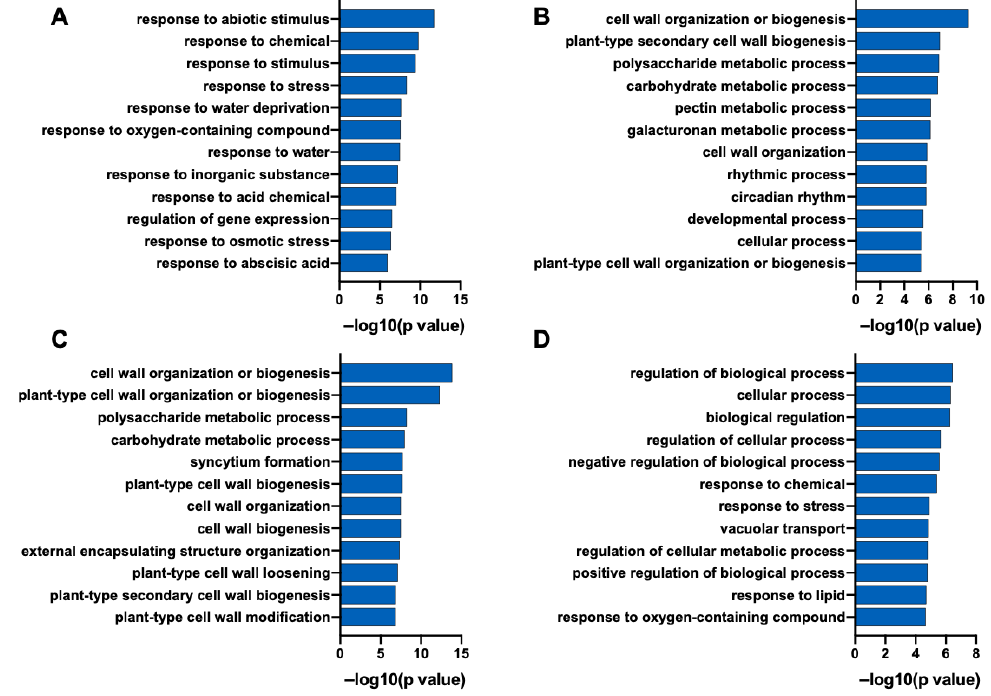
Figure 8. A GO enrichment analysis of DEGs in PsnWRKY70 transgenic poplar. ( A ) A GO enrichment analysis of uniquely upregulated genes in OE lines. ( B ) A GO enrichment analysis of uniquely downregulated genes in OE lines. ( C ) A GO enrichment analysis of uniquely upregulated genes in RE lines. ( D ) A GO enrichment analysis of uniquely downregulated genes in RE